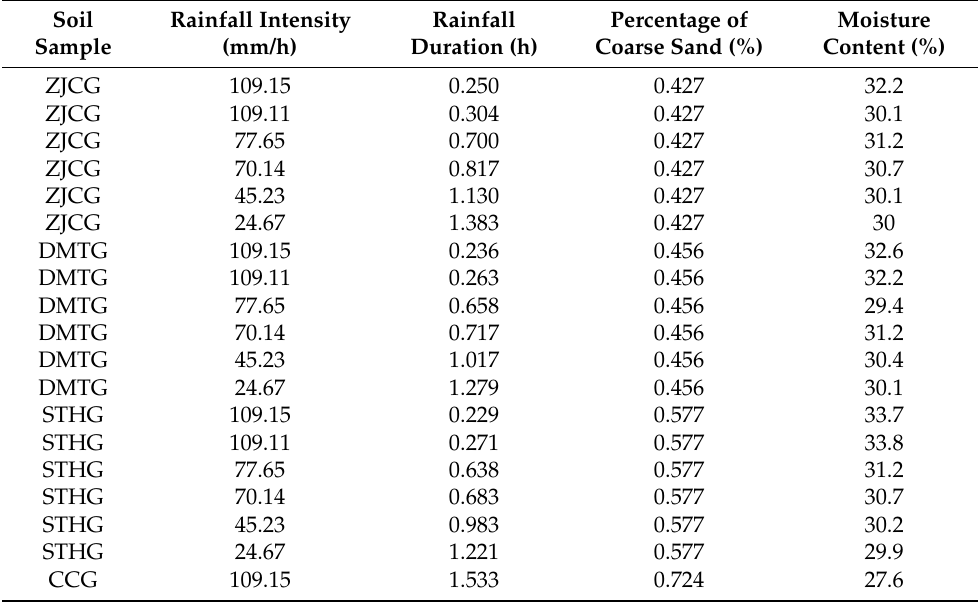
Table 6. Statistical table of parameters data of physical model